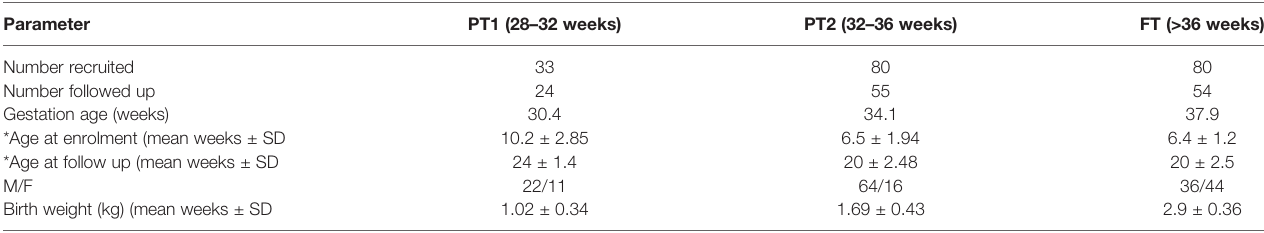
TABLE 1 | Demographic characteristics of study